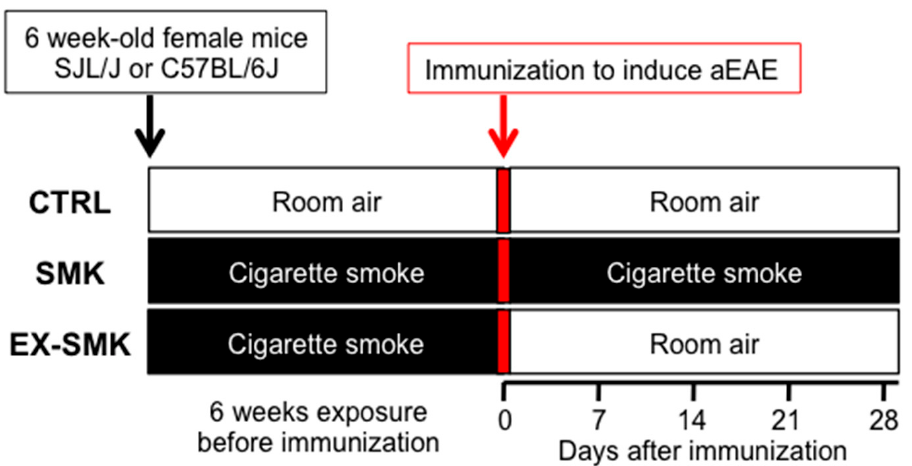
Figure 3. Experimental setup. Sequence of smoke exposure experiments in actively induced EAE mouse models is shown.